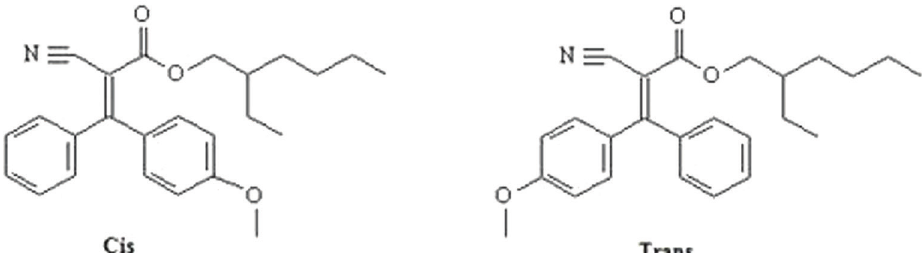
FIGURE 1 - Chemical structure of cis and trans isomers of ethylhexylmethoxycrylene (EHMCR) (Source: adapted of Bonda, Zhang,